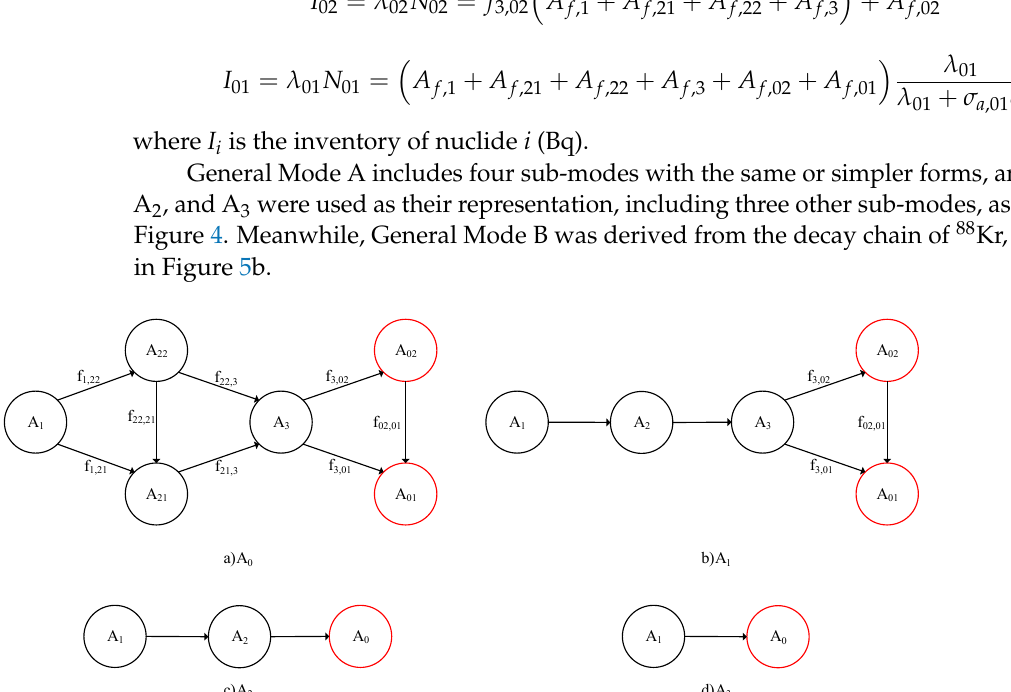
Figure 5. General Mode B for the decay chain. Hence, the equilibrium inventory of the fission gas nuclide i ( I i ) can be obtained from the linear combination of the source of nuclide j in the entire decay chain of nuclide i ( A f , j ) and can be expressed as Equation (14). Additional details are provided in Table 2. All justification of equations is discussed in the supporting information. 𝐼 (cid:3036) = 𝑔(cid:3435)𝐴 (cid:3033) , (cid:3037) (cid:3439) = (cid:3533) 𝛼 (cid:3037) , (cid:3036) 𝐴 (cid:3033) , (cid:3037) (cid:3037)